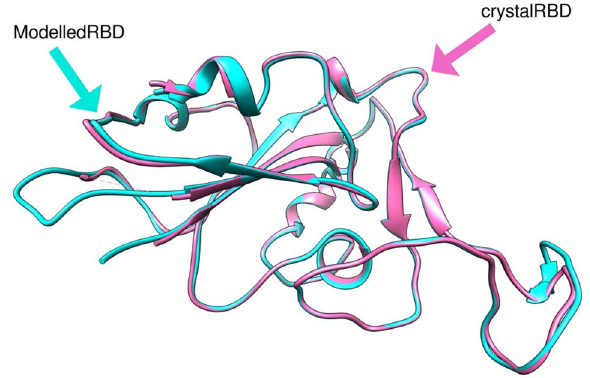
Figure 4. 3D structure of SARS-CoV-2 S protein (PDB ID 6M0J (open form) and the homology modelled structure from Modeller. This demonstrates the very high structural similarity of our homology modelled spike protein structure with the EM structures (PDB ID 6M0J (RBD)), with an RMSD of 0.36